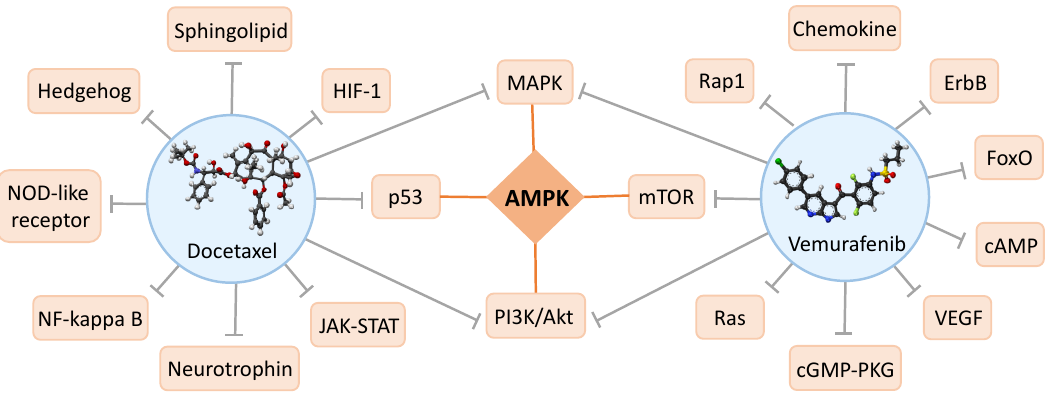
Figure 8. Docetaxel, Vemurafenib and targeted pathways.